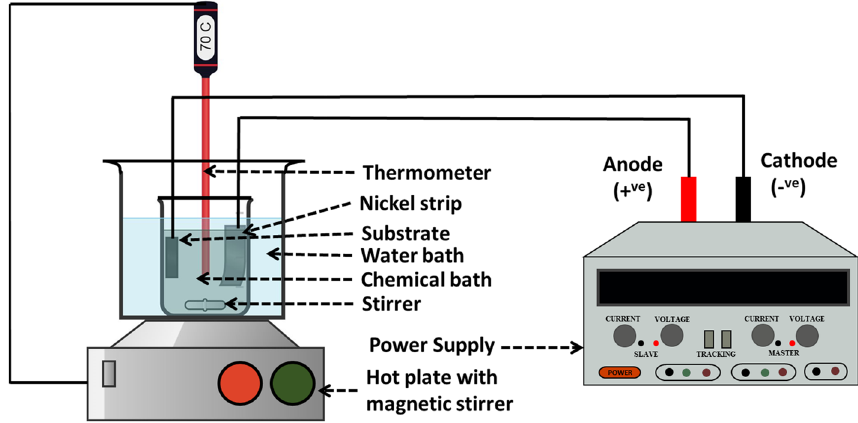
Figure 1. Schematic diagram of the electrodeposition process to develop Ni–P–TiC composite coatings.